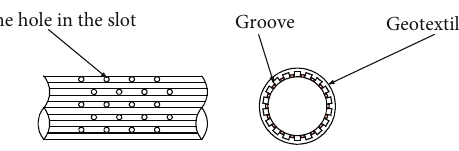
Figure 1: The slotted tube